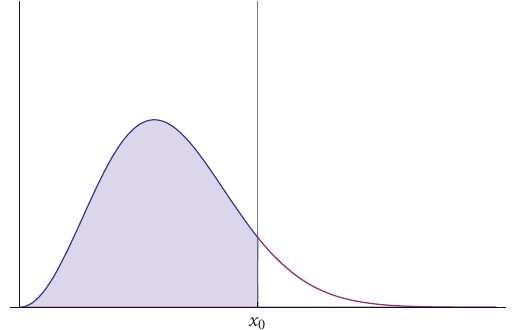
Figure 5: Probability density function for the theoretical variable x . The shaded area is the probability